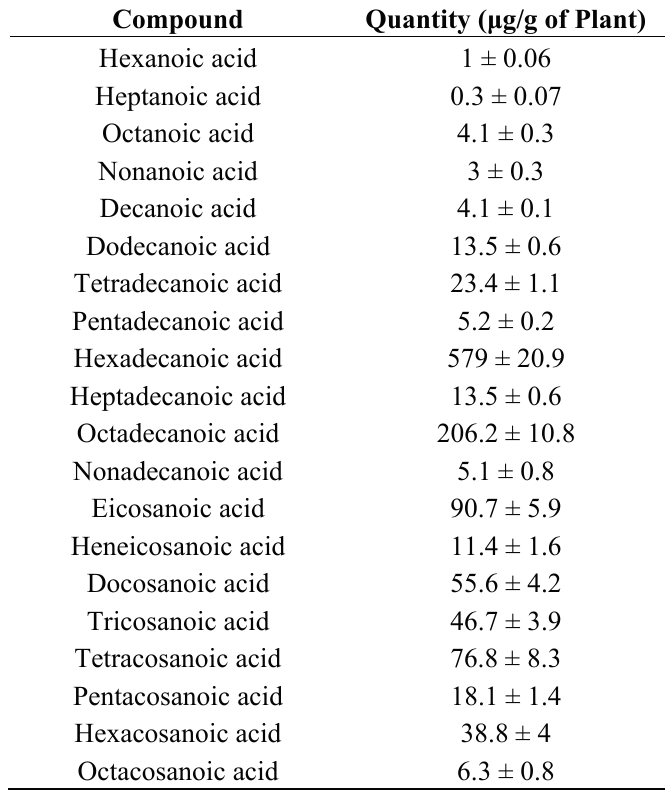
Table 1. Quantities of different families of compounds in the scCO 2 maize stover wax in μ g/g of